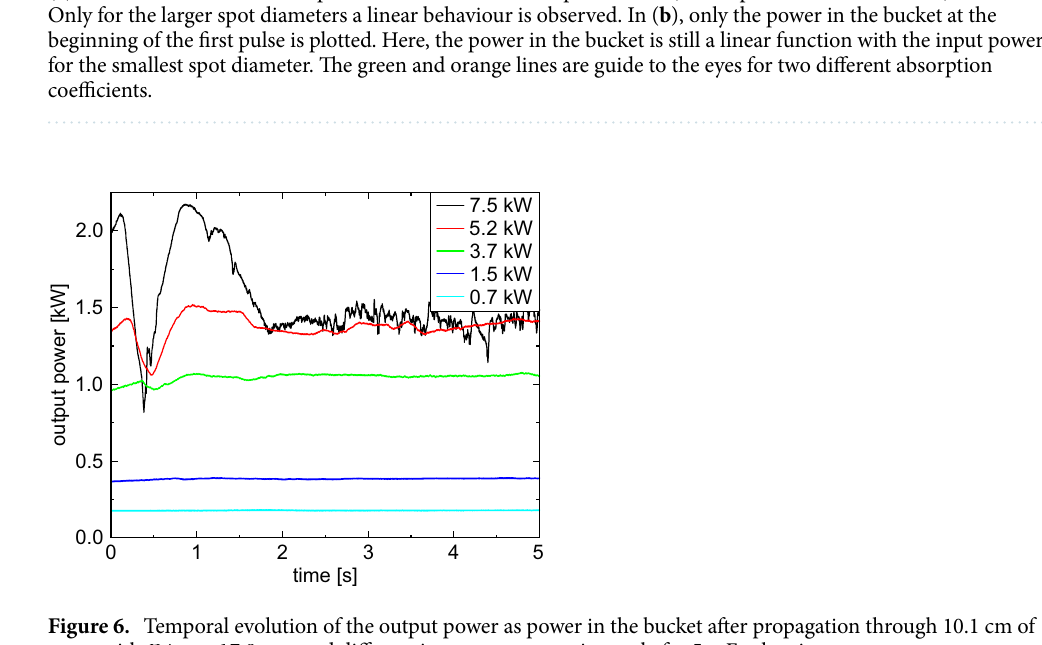
Figure 6. Temporal evolution of the output power as power in the bucket after propagation through 10.1 cm of water with D 4 σ = 17.8 mm and different input powers continuously for 5 s. For low input powers, a constant power in the bucket is observed, while for high input powers, a characteristic change with increasing magnitude is